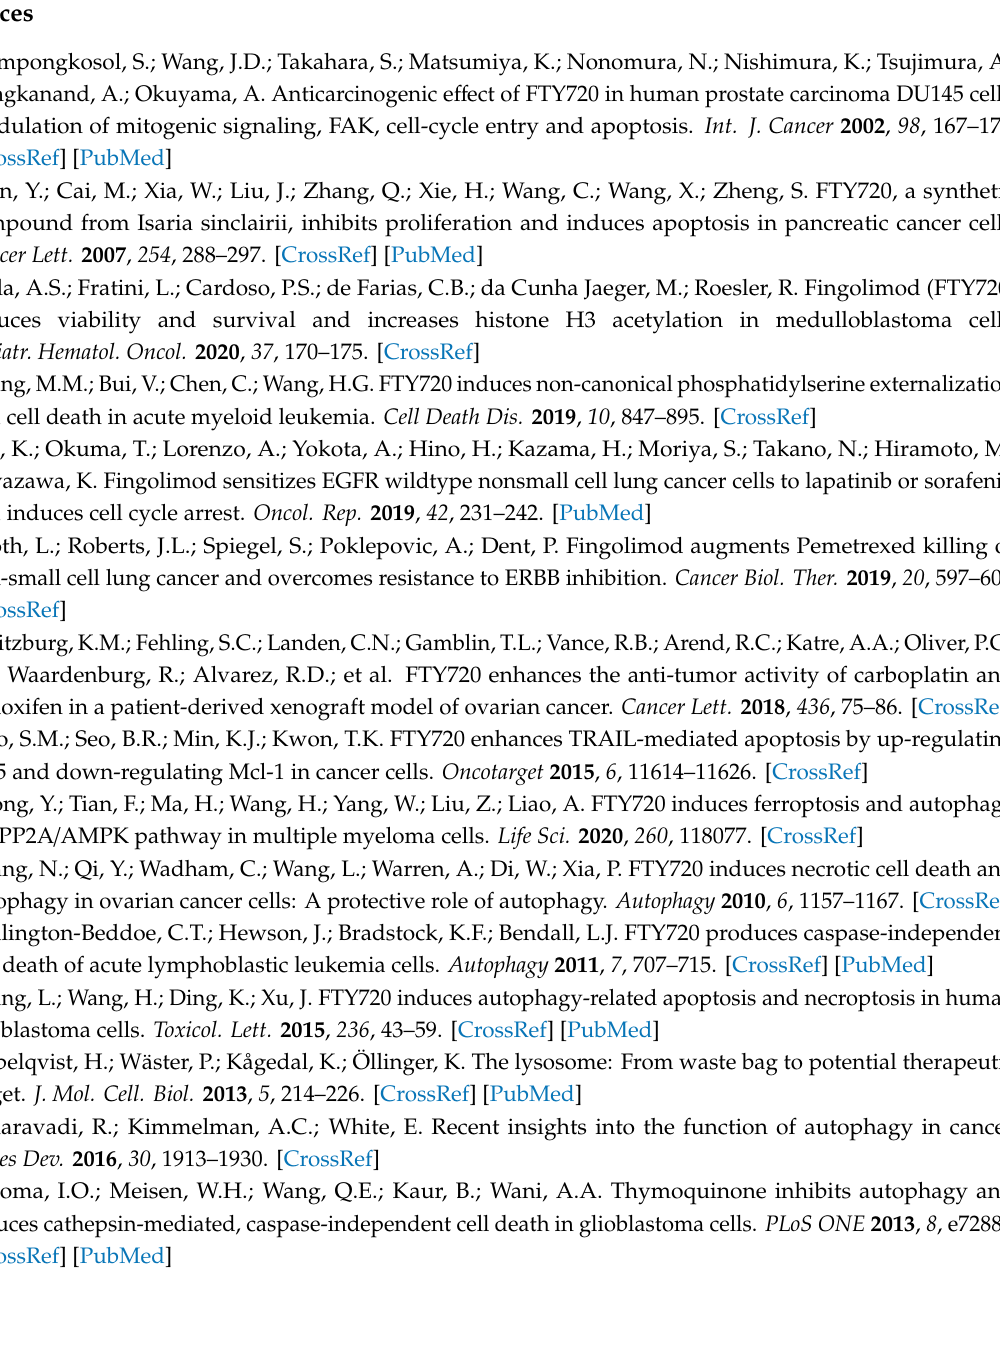
Figure S1: E ff ect of 3-MA on PP242 plus curcumin-induced apoptosis. Figure S2: E ff ect of various inhibitors on cancer cells. Figure S3: E ff ect of NAC and GEE on FTY720-induced ROS generation in U251MG cells. Figure S4. E ff ect of apoptosis, necroptosis, and autophagy inhibitors on FTY720-induced cell death. Figure S5. E ff ect of HSP70 inhibitors on FTY720-induced cell death. Figure S6: Uncropped western blot image for Figure 1, Figure 2, Figure 3, Figure 4, Figure